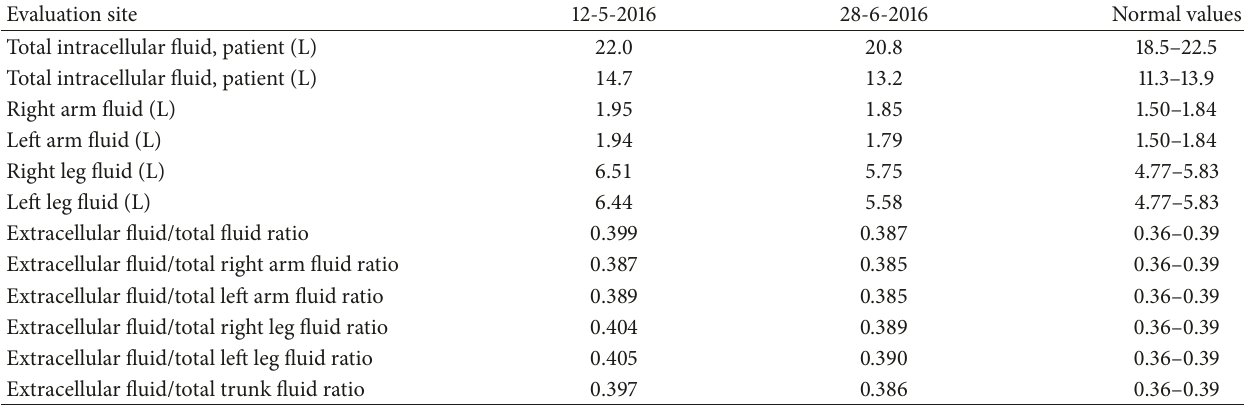
Table 1: Table 1 shows the total intracellular and extracellular fluid volume of the limbs and trunk before and after treatment and the ratio of extracellular water to total